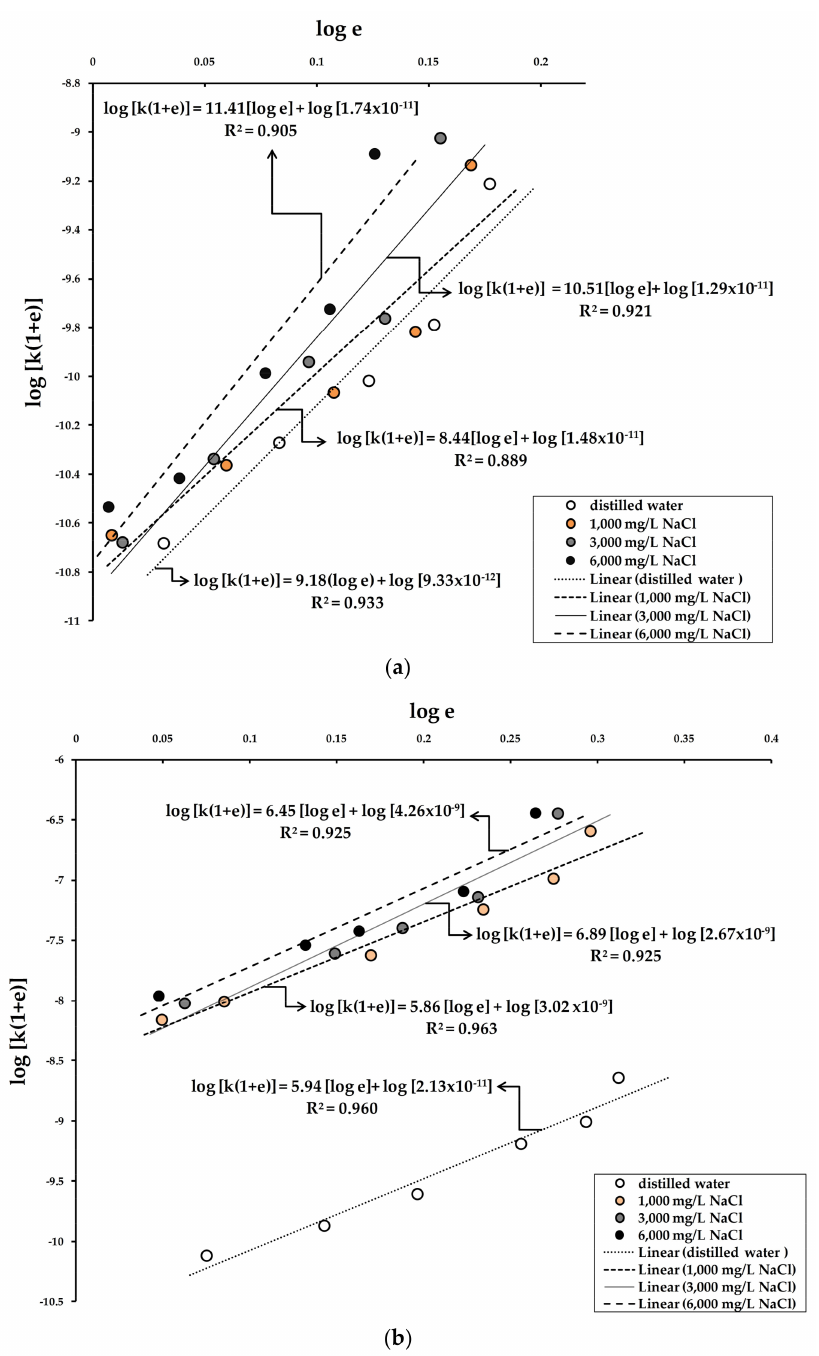
Figure 12. Mathematical relationship of hydraulic conductivity to void ratio for: ( a ) Semarang clay; ( b ) Demak